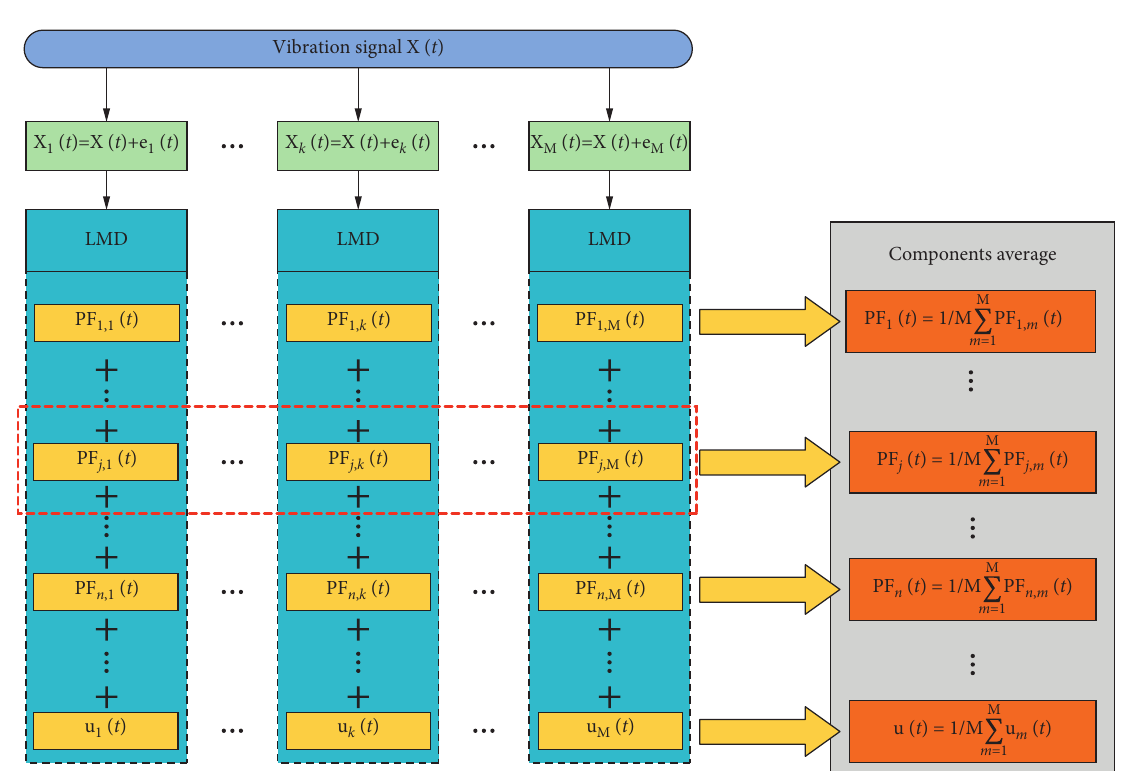
Figure 2: The main steps of decomposing enhanced PF components with the proposed